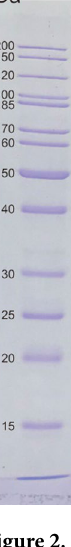
Figure 2. SDS-PAGE of purified PBOR_28850. One microgram of purified PBOR_28850 was analyzed. Lane M, standard of molecular mass. The image of the upper and lower parts of the gel was cropped. The gel image was cropped vertically to eliminate redundant part, but not horizontally. Unprocessed image is shown in Supplementary Fig.